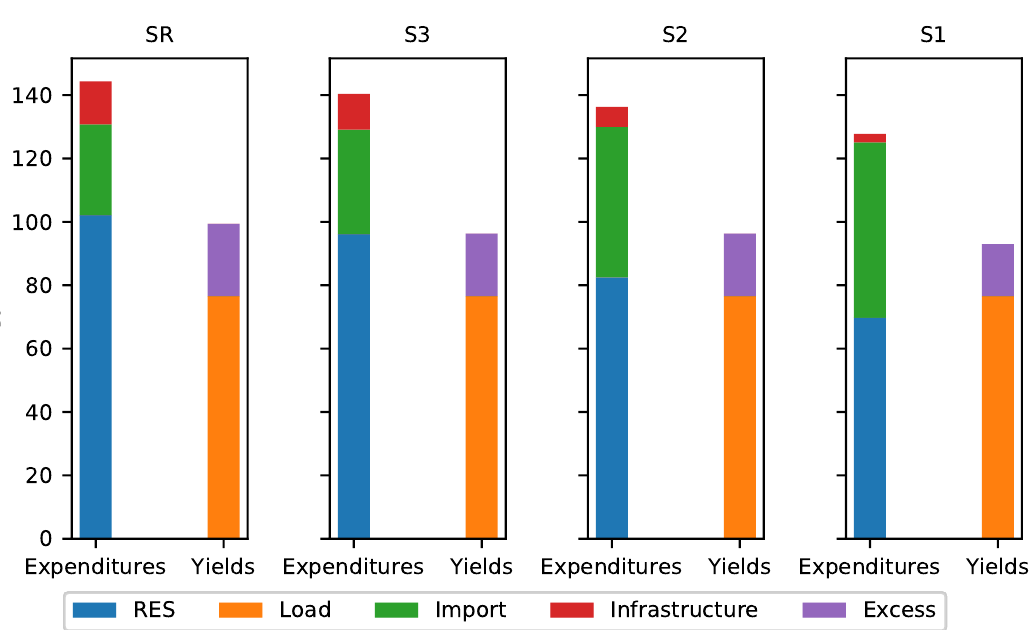
Figure 5. Exergy expenditures and yields of the different scenarios. Expenditures include CExC from energy sources, RES, and for RES and infrastructure investment. The yields include the exergy for the load and excess exergy. (Source: own